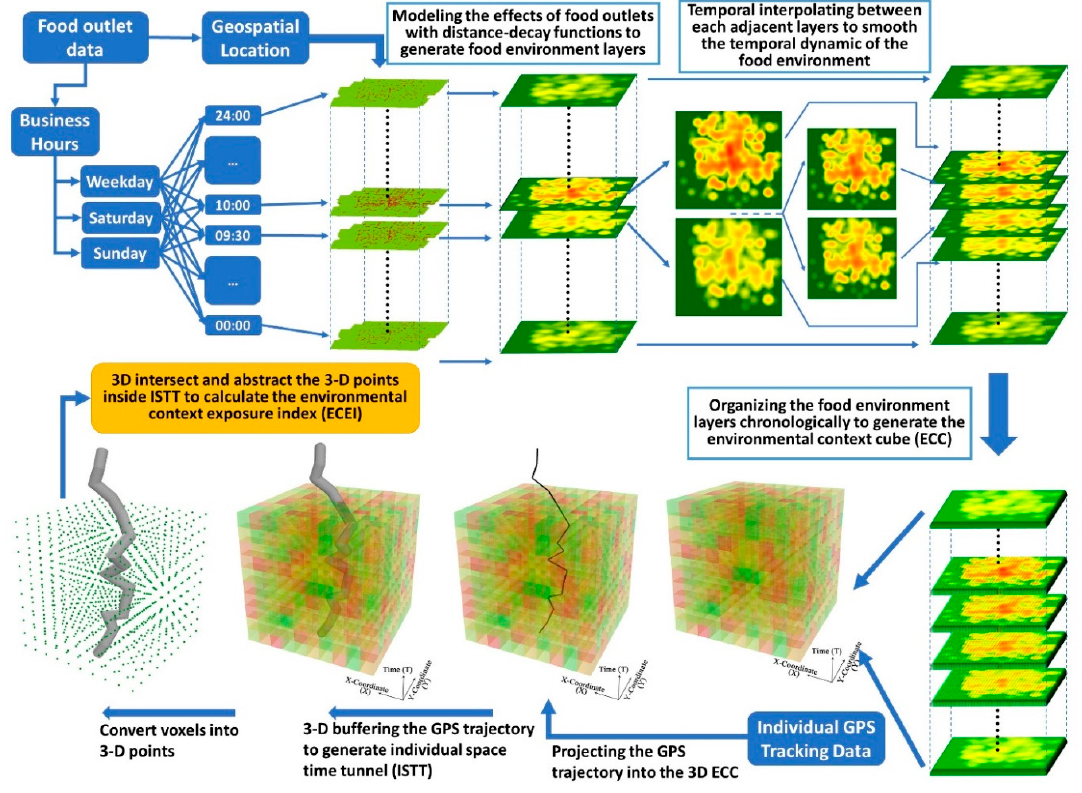
Figure 1. The proposed analytical framework.